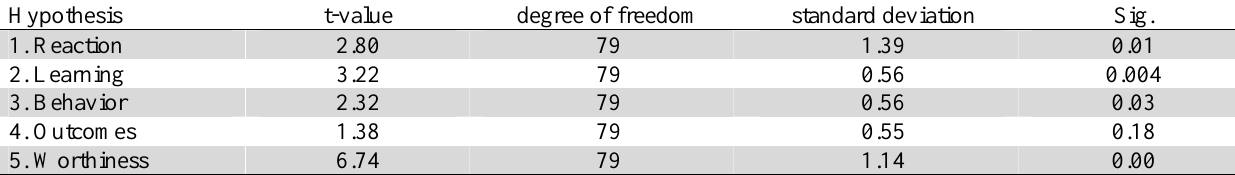
t-value degree of freedom standard deviation Sig.